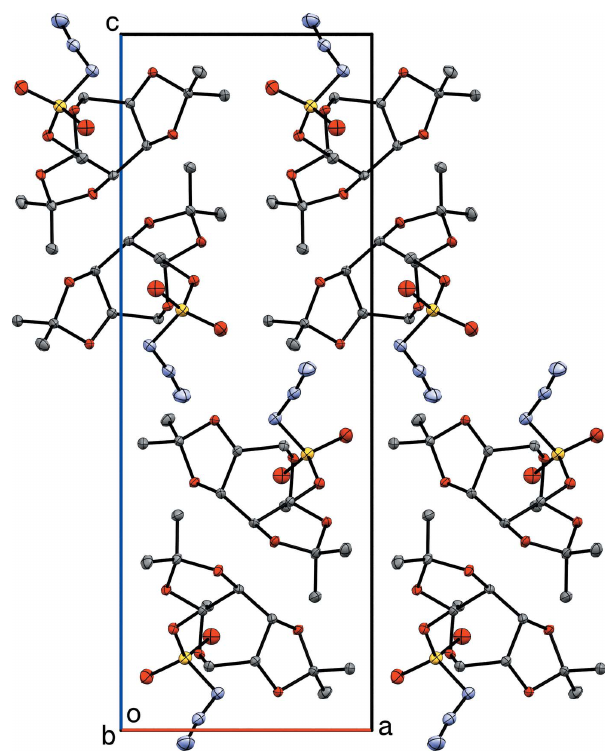
Figure 4 A packing plot of I viewed in projection down the b -axis, showing segregation of like groups, leading to the formation of double layers parallel to the ab plane. Diagram generated using Mercury (Macrae et al. , 2020).